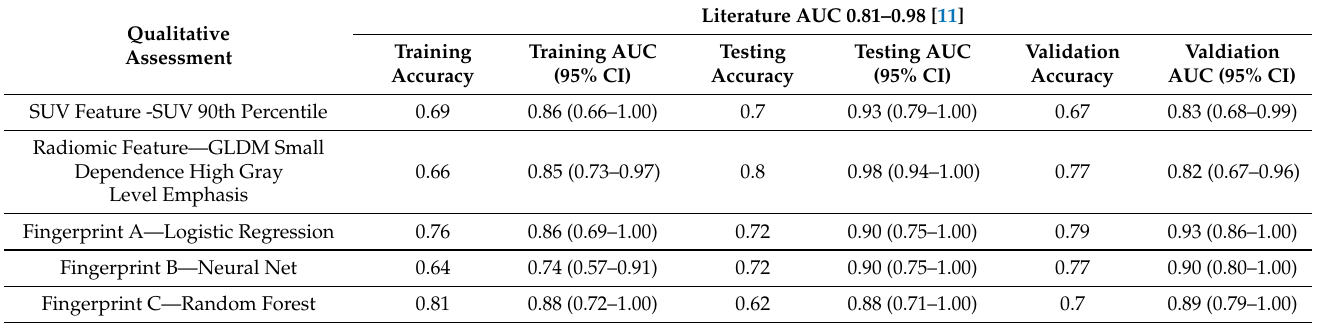
Table 6. A summary of the diagnostic utility of each explored method when feature harmonization is applied.